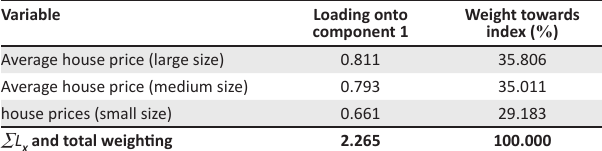
TABLE 5: Component loadings of South African house price conditions.